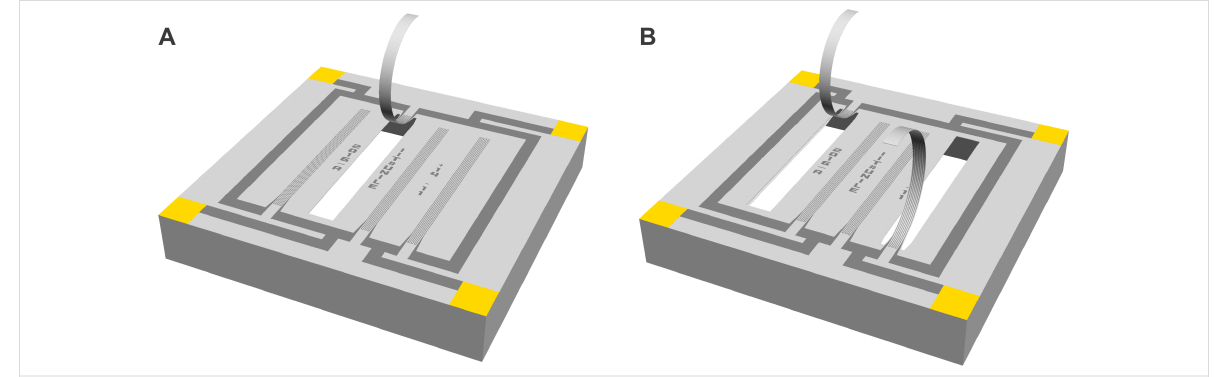
Figure 3: CAD models of the single and antiparallel hair flow sensor with strain gauges bent out-of-plane. (A) Single strain gauge forms a Wheat- stone quarter-bridge, whereas (B) antiparallel strain gauges form a Wheatstone half-bridge configuration.